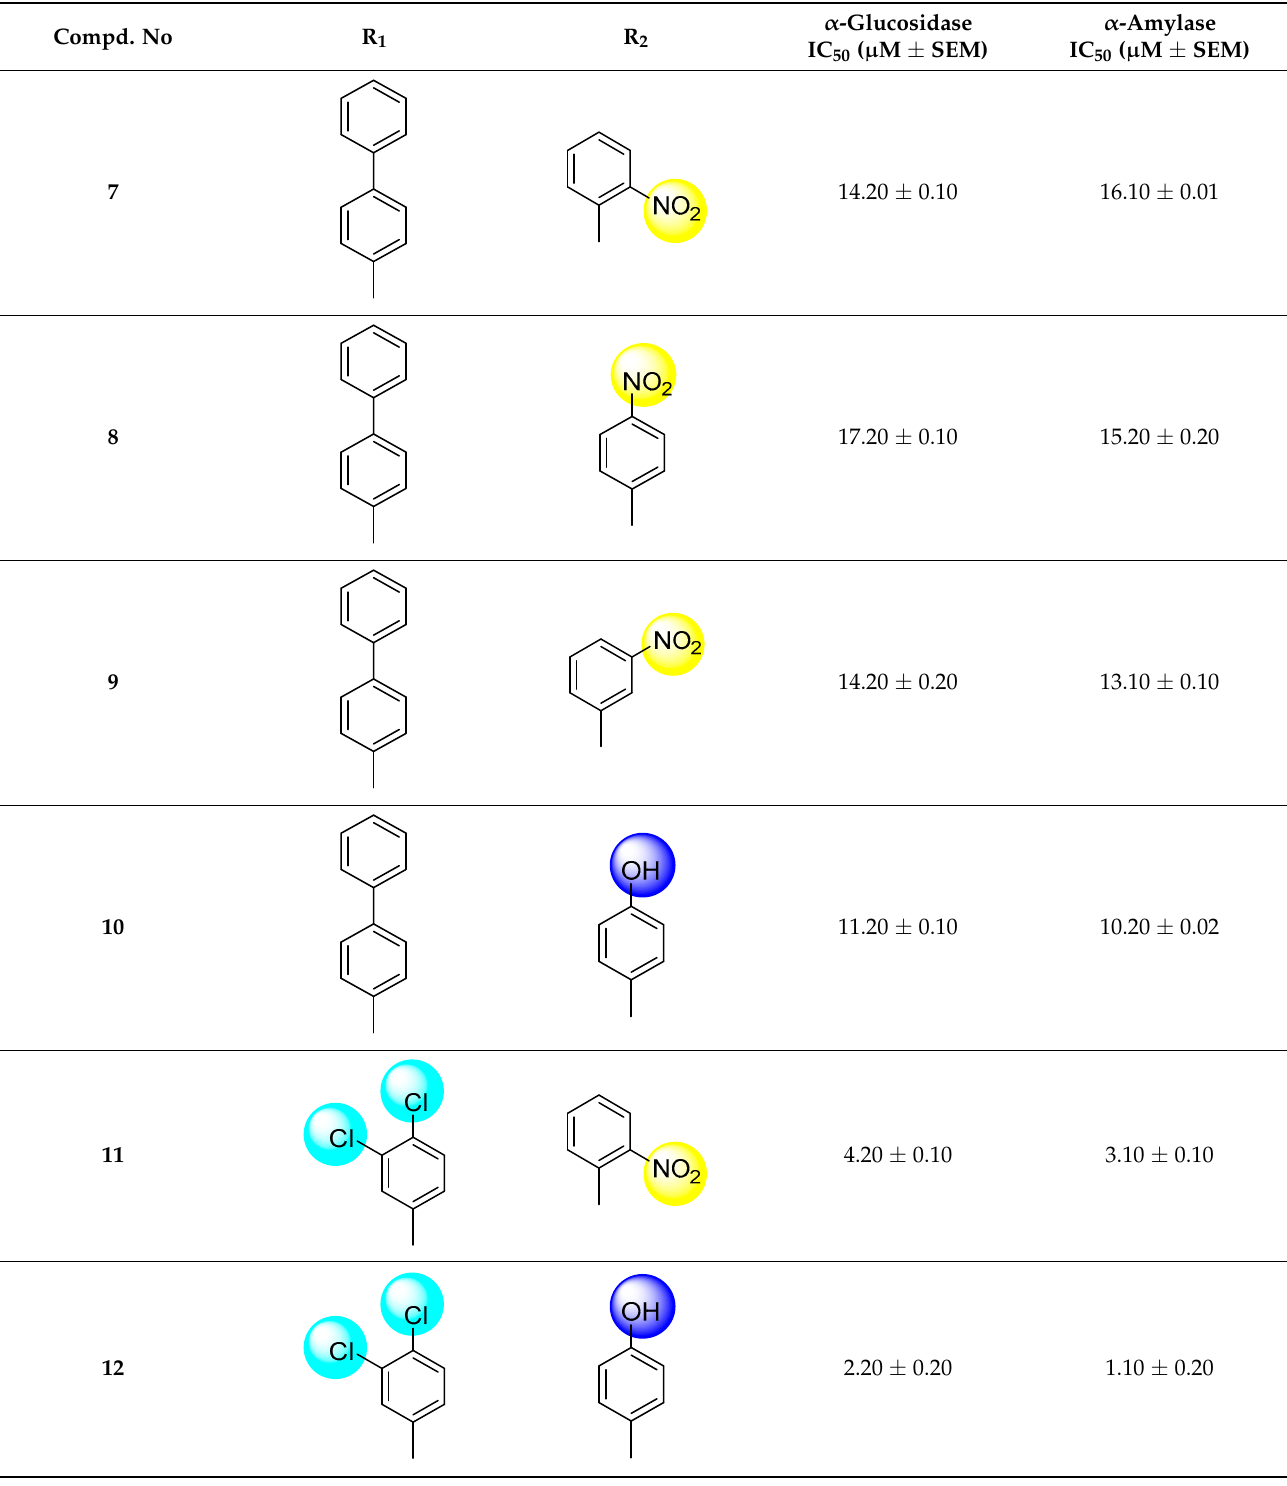
Table 1. Different substituents and α -glucosidase and α -amylase inhibitory activities of benzimid- azole bearing thiosemicarbazone derivatives ( 7–21 ).